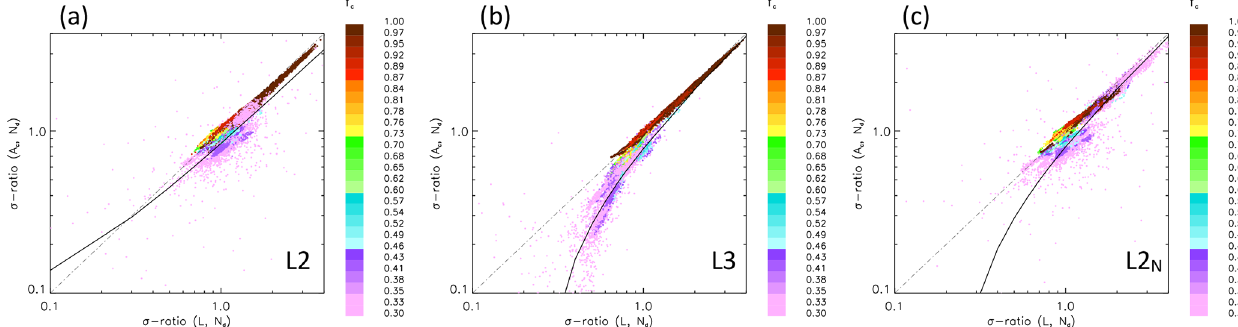
Figure B2. Plots of the σ ratio (Eq. 13) for A c , N d ( σ ratio – A c , N d ) vs. L , N d ( σ ratio – L , N d ). The solid lines are best-fit lines to the low- f c points. The dash-dotted line is the 1 : 1 line. Note that the log scale distorts the solid-line linear relationships. (a) L2, (b) L3, and (c) L2 N . See Appendix B for further